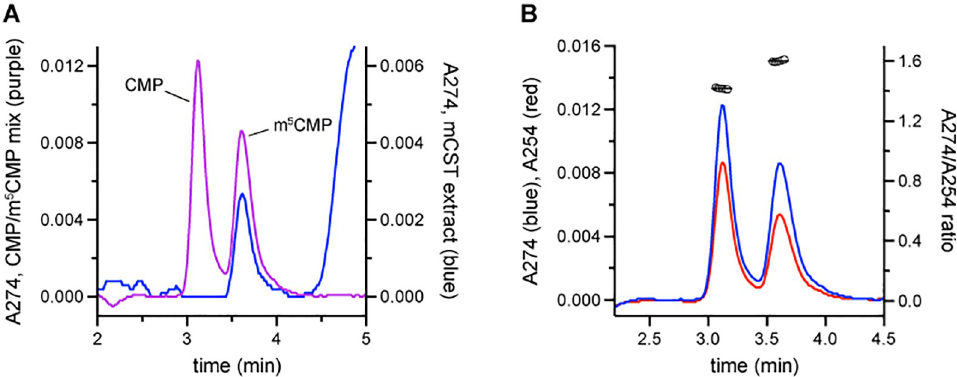
Fig 3. Comparison of m 5 CMP with the molecule that co-purifies with CST. A) The aqueous layer of a phenol- chloroform extraction of purified CST was run on a C18 HPLC column (blue trace). A separate sample containing 5 μ M each of CMP and m 5 CMP was also run (purple trace). B) For the sample containing CMP and m 5 CMP, shown in panel A, the absorbance was monitored at both 274 nm (blue trace) and 254 nm (red trace) which is shown here. The ratio of the absorbance at these two wavelengths for a given time is plotted as the open circles on the right y-axis. The black horizontal lines represent the average A274/A254 ratio for the two peaks.